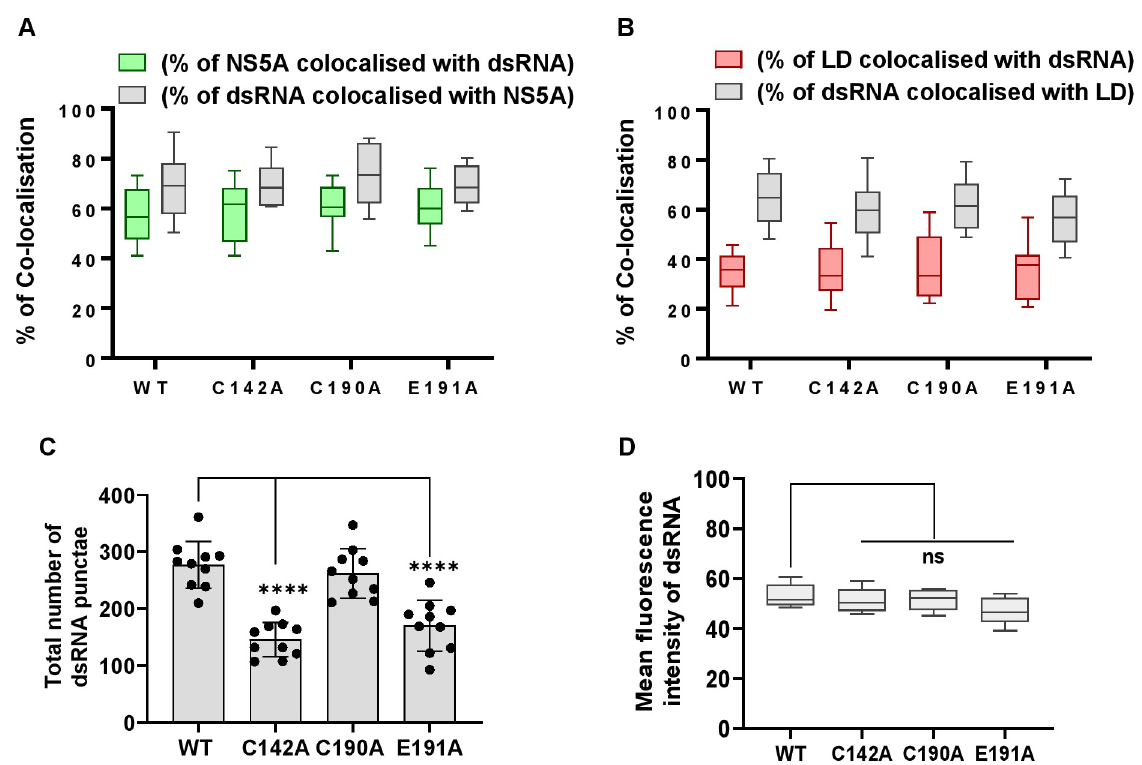
Fig 11. Quantification of dsRNA punctae and co-localisation with NS5A and LD. ( A) Quantification of the percentage of NS5A colocalized with dsRNA (green), and dsRNA colocalized with NS5A (grey). ( B) Quantification of the percentage of LD colocalized with dsRNA (red), and dsRNA colocalized with LD (grey). Co-localisation was analyzed in 10 cells from Fig 10 using Fiji. (C) Numbers of dsRNA punctae of each sample were calculated using the Analyze Particles module of Fiji. 10 cells were analysed for each sample. Significant differences from WT denoted by ns (P > 0.05), ���� (P < 0.0001). (D) Total fluorescence of dsRNA staining was quantified by Fiji and presented as arbitrary